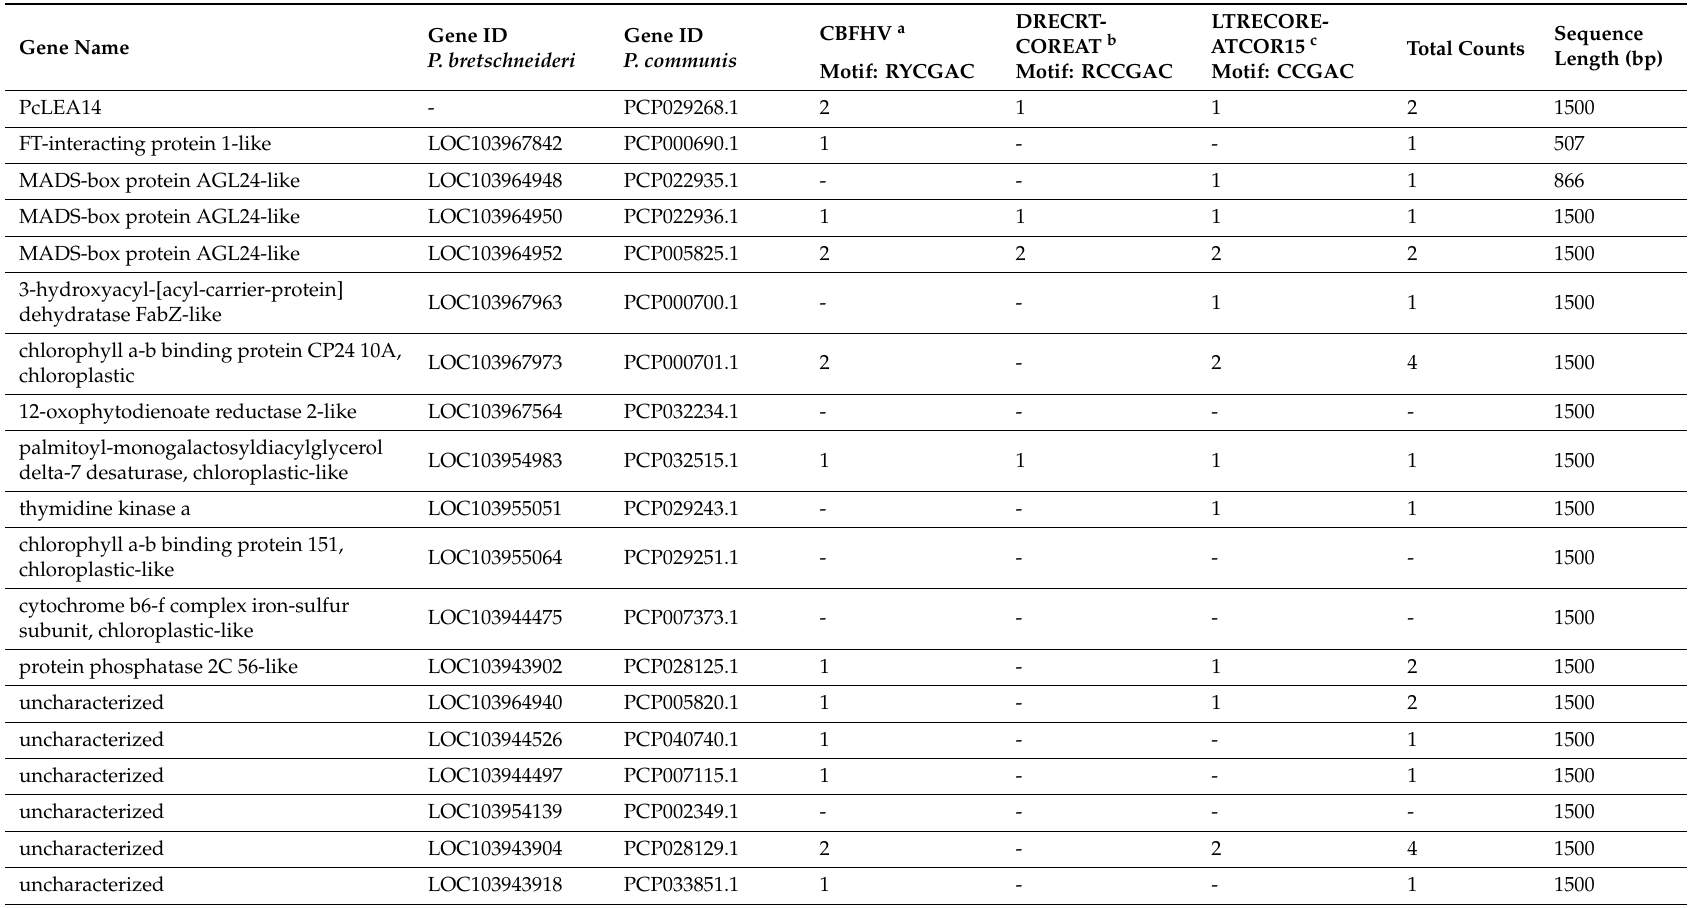
Table 1. CRT / DRE motif and LTRE motif on the promoter of PcLEA14 and candidate genes playing a role during